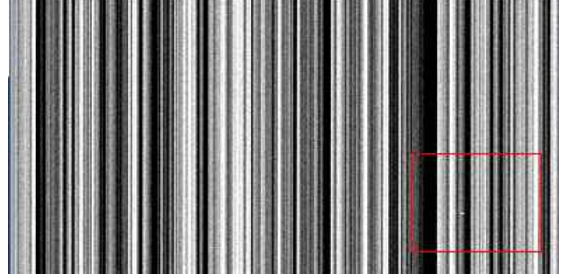
Figure 10 : example of slow-motion